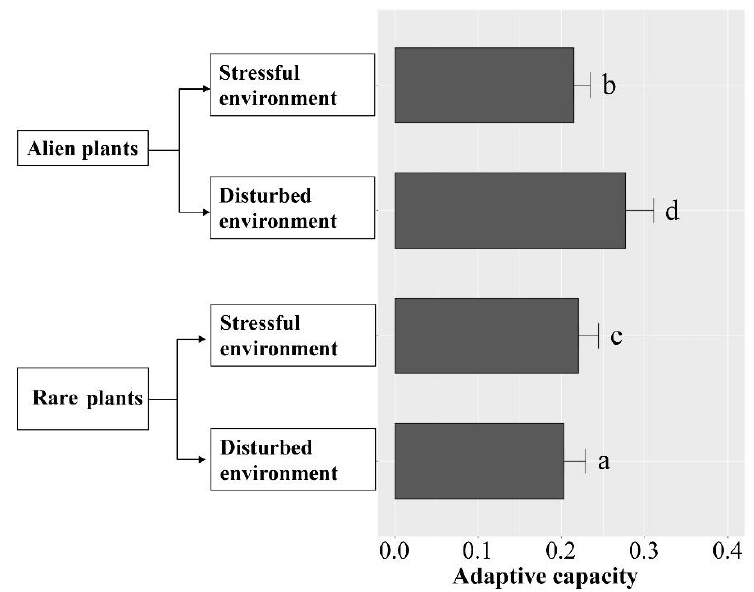
Figure 6. Differences in the adaptive capacities between alien and rare plants to stressful and disturbed environments. Error bars represent standard deviation, different letters indicate significant differences among adaptive capacities ( p < 0.01).